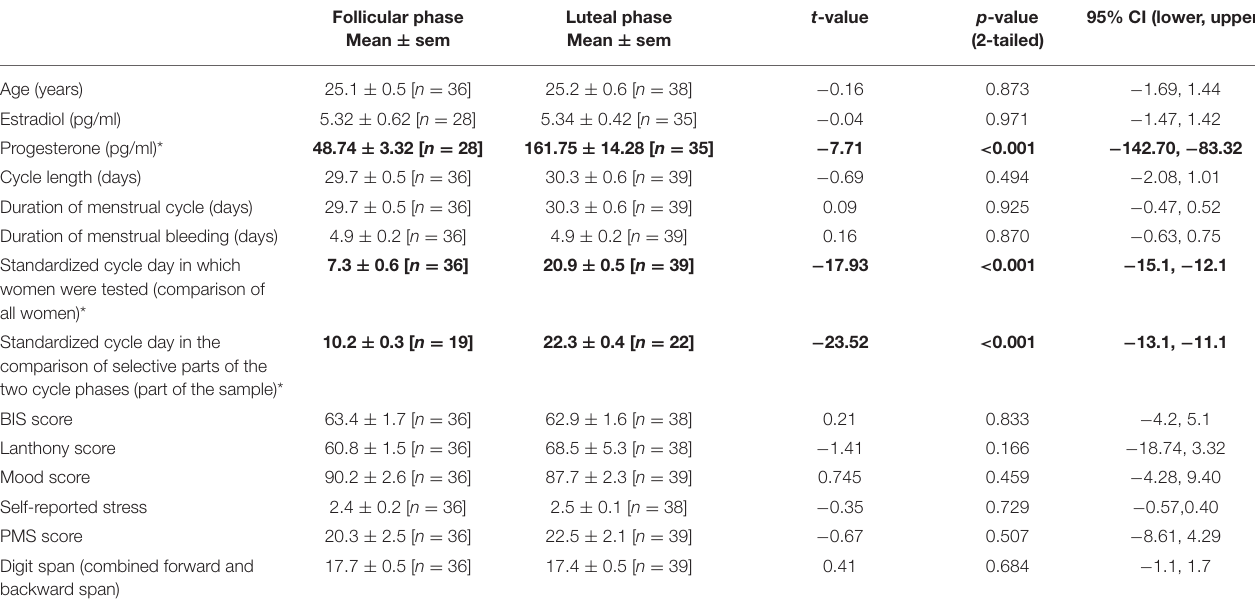
TABLE 1 | Demographic characteristics of the